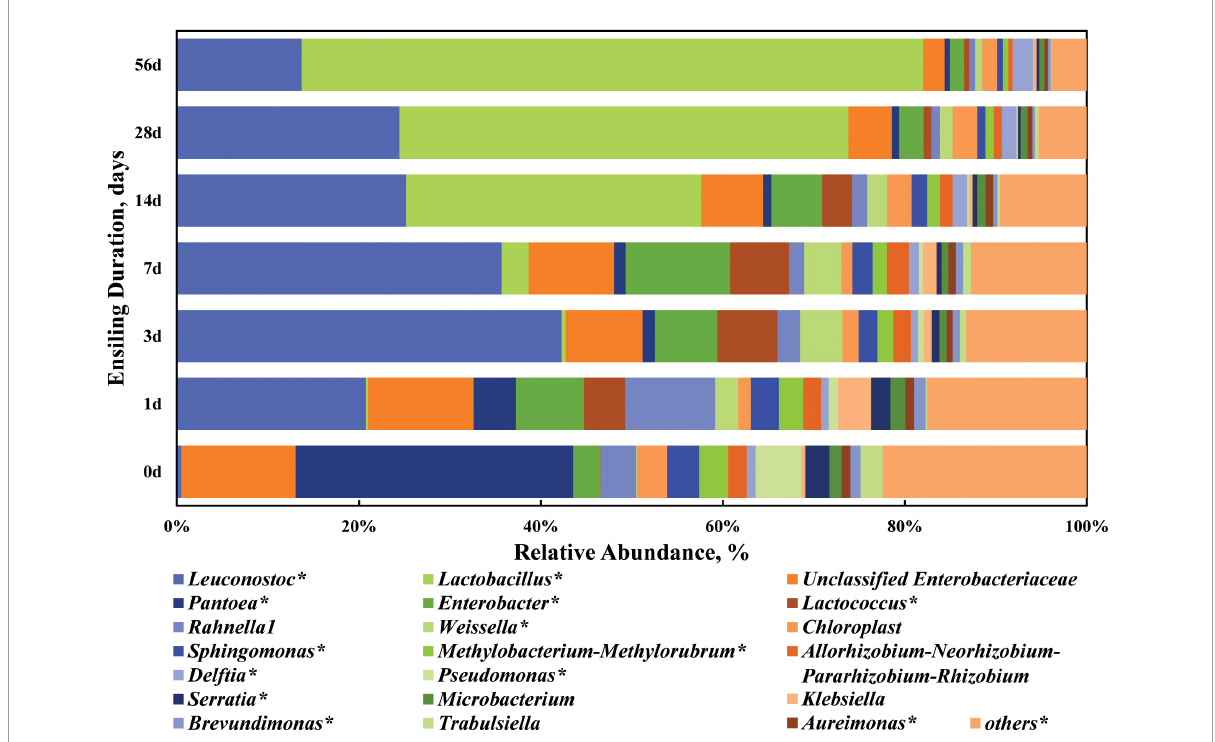
FIGURE4 Dynamic changes of the top 20 abundant bacterial taxa at the genus level in the sorghum stalk silage with ensiling duration. Taxa name with asterisk (*) denoted highly significant ensiling duration effect ( P <